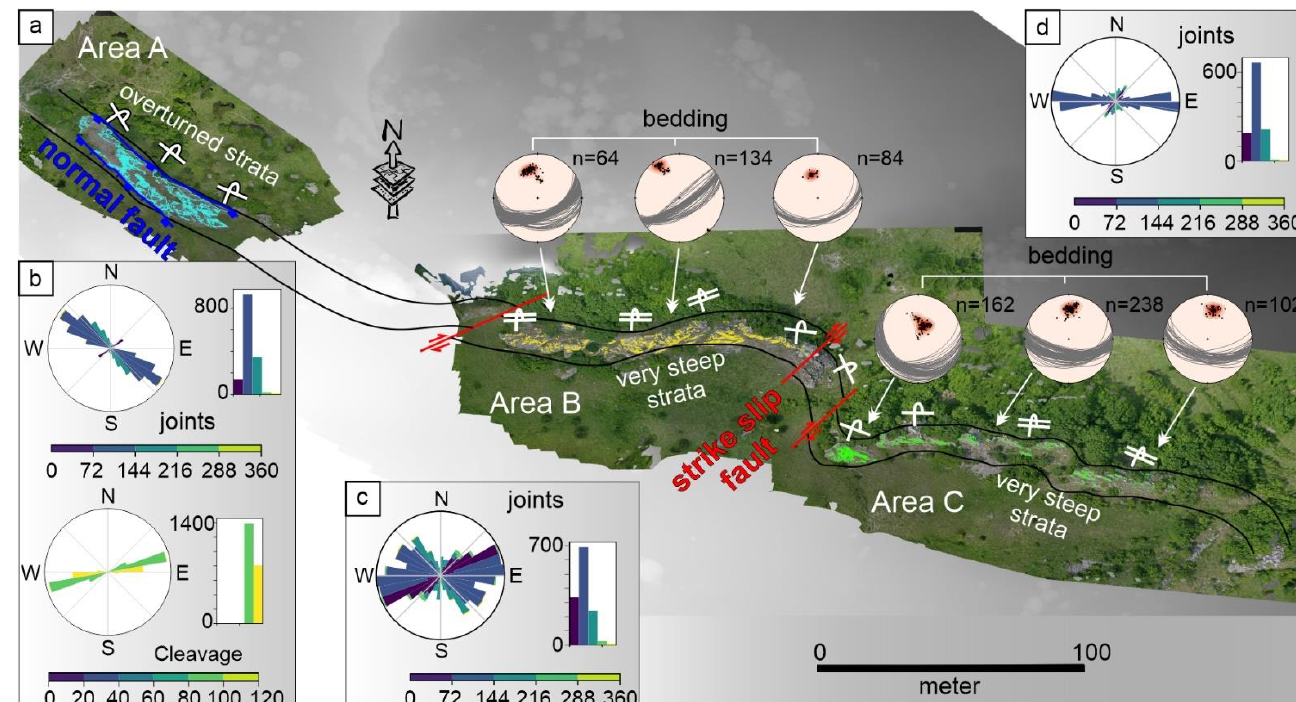
Figure 11. ( a ) Overall view of the study area and geometric evolution of the RCC in A, B, and C areas. The stereoplots in panel ( a ) were extracted with the Virtual Compass tool from the CloudCompare software. The rose diagrams of panels ( b ), ( c , d ) were extracted with the GeoTrace plugin in QGIS.